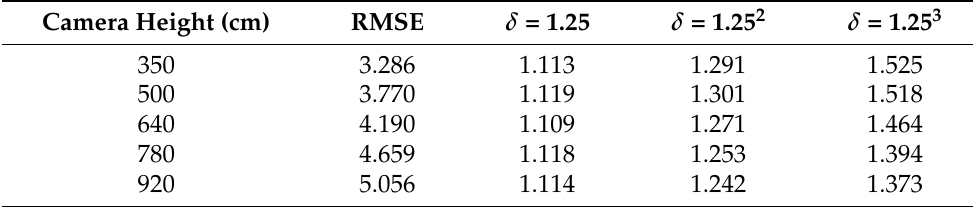
Table 1. Height Estimation Results on generated height dataset using CARLA simulator.